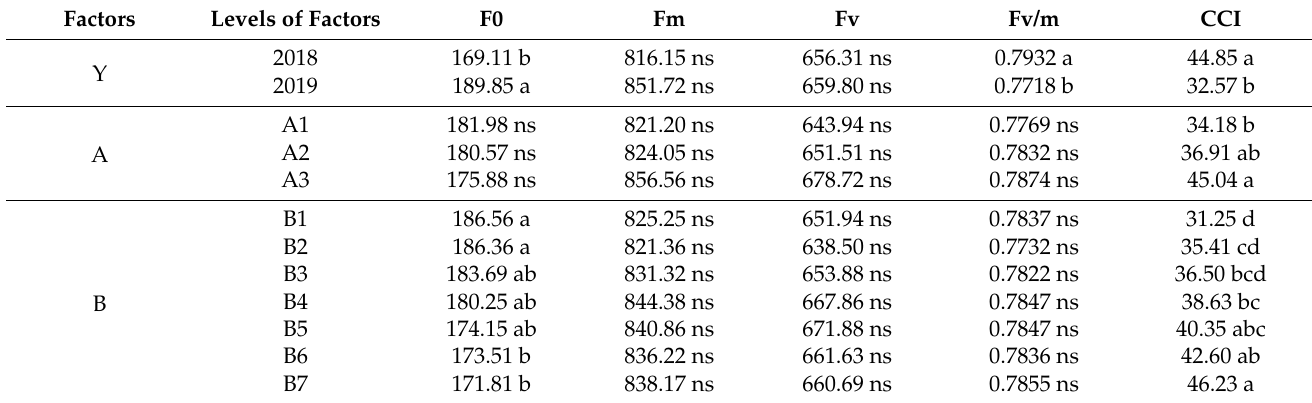
Table 9. Average values of physiological data for years (Y), cultivars (A) and type of fertilizer